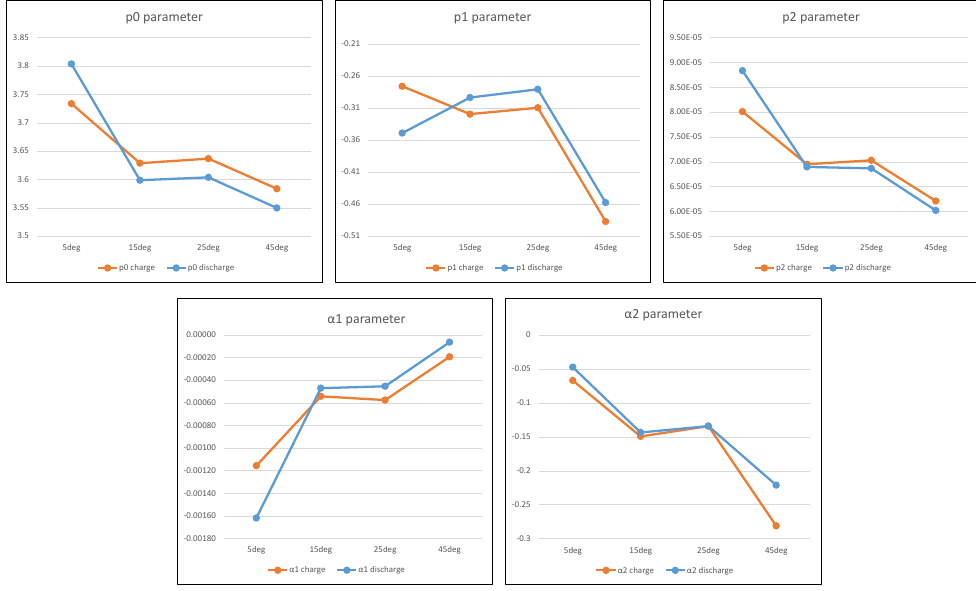
Figure 11. The linear interpolation of the proposed OCV model for the [5–45 ◦ C] temperature range.